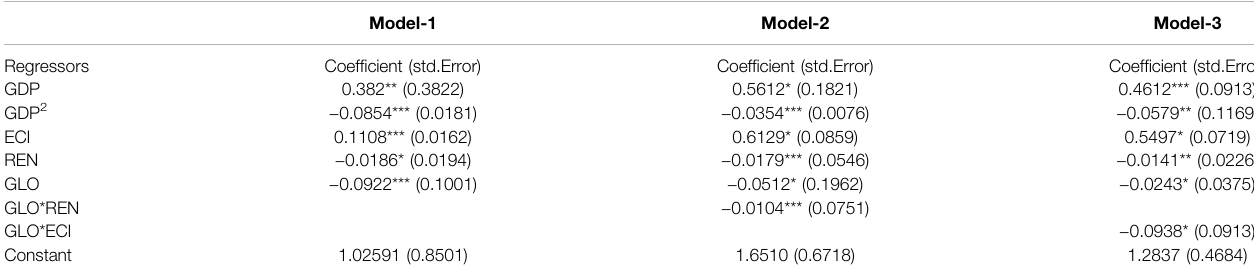
TABLE 8 | Robustness check (CCEMG) outcomes.